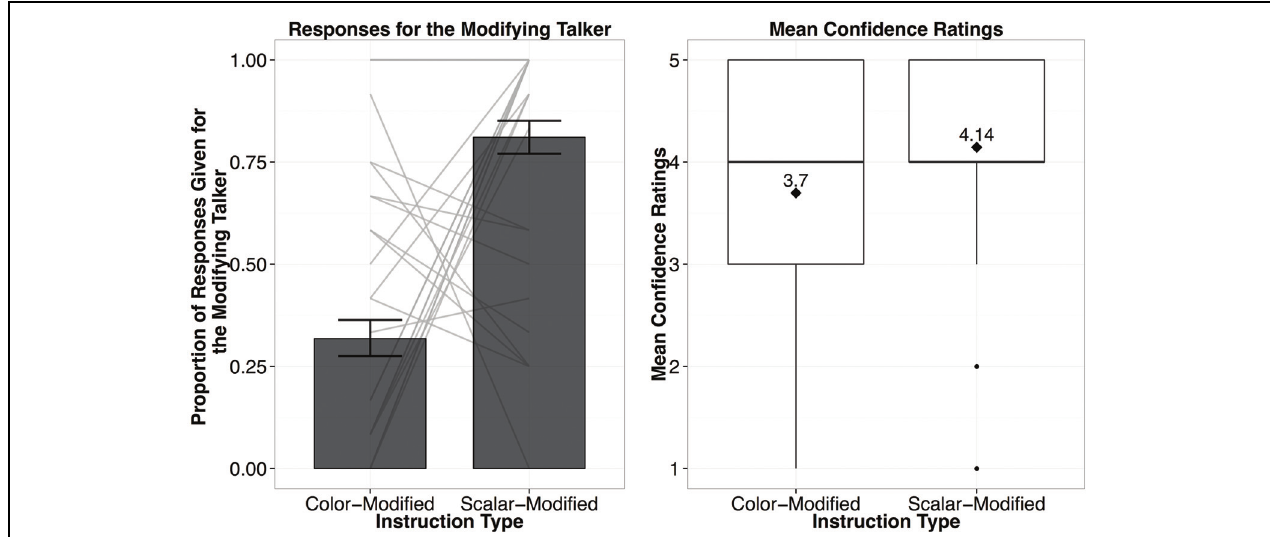
FIGURE 4 | Results from Experiment 2A, showing the proportion of responses given for the modifying talker by Instruction Type (left; light gray bars reflect individual participant means), and the confidence ratings for responses by Instruction Type (right; diamond dots reflect the mean rating out of